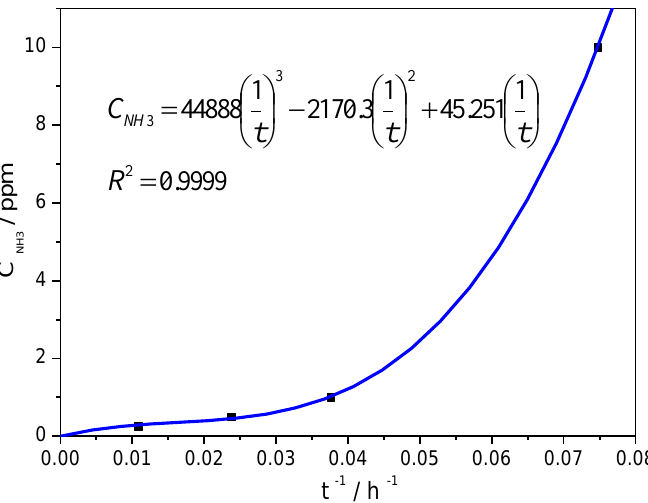
Figure 10. Relationship between the concentration of NH 3 and the maintained time allowed for a cell voltage drop of 25 mV. cell voltage drop of 25